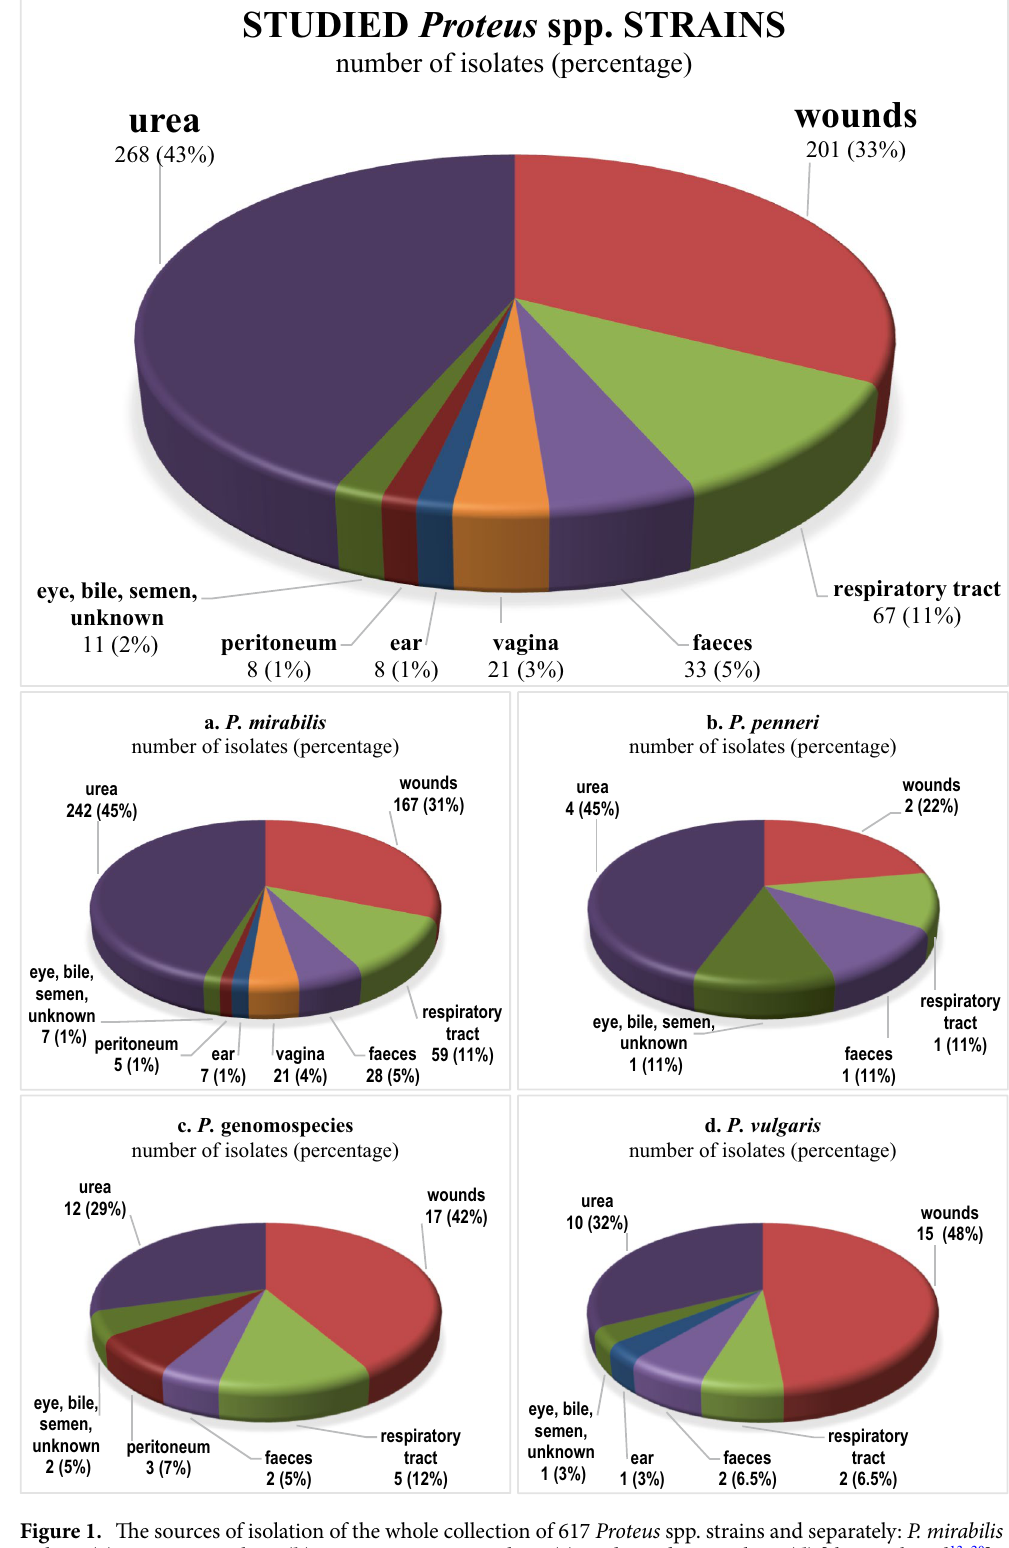
Figure 1. The sources of isolation of the whole collection of 617 Proteus spp. strains and separately: P. mirabilis isolates ( a ), P. penneri isolates ( b ), P. genomospecies isolates ( c ), and P. vulgaris isolates ( d ) [this work and 13–20